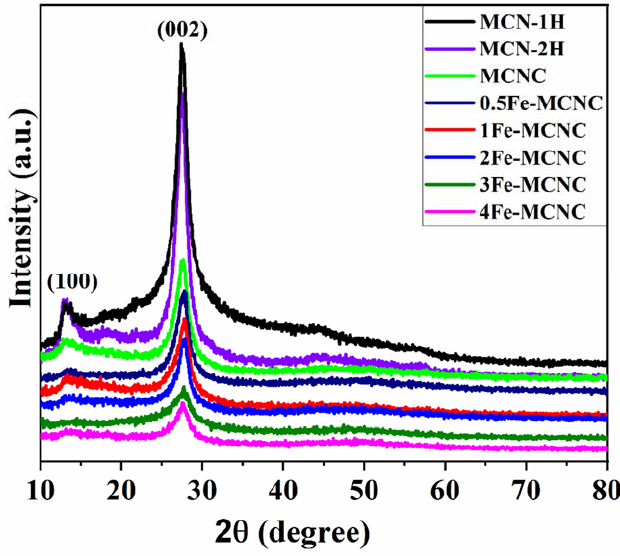
Figure 3. XRD patterns of the MCN and Fe ‐ MCNC nanostructures.